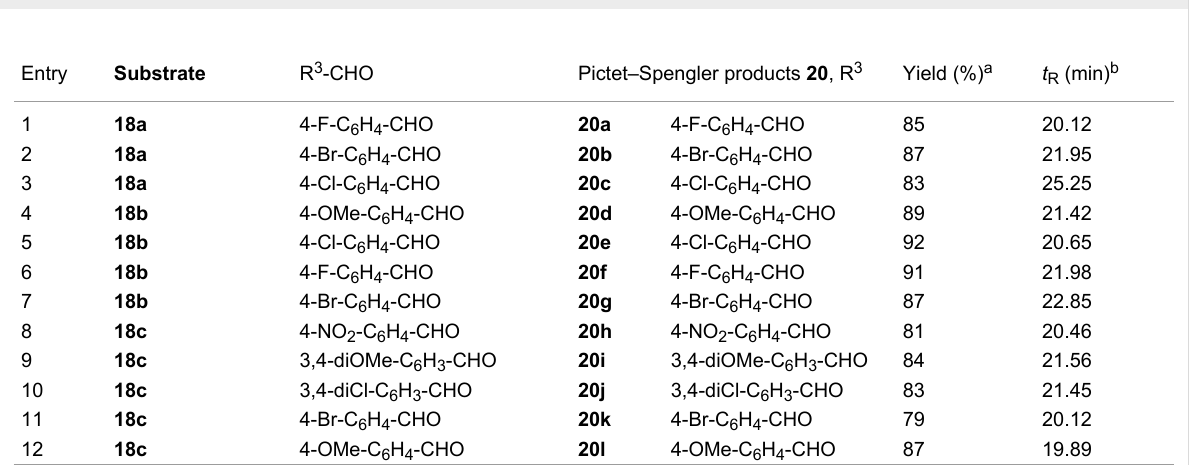
Table 3: Pyrimido[5,4- c ]isoquinolines based on 20